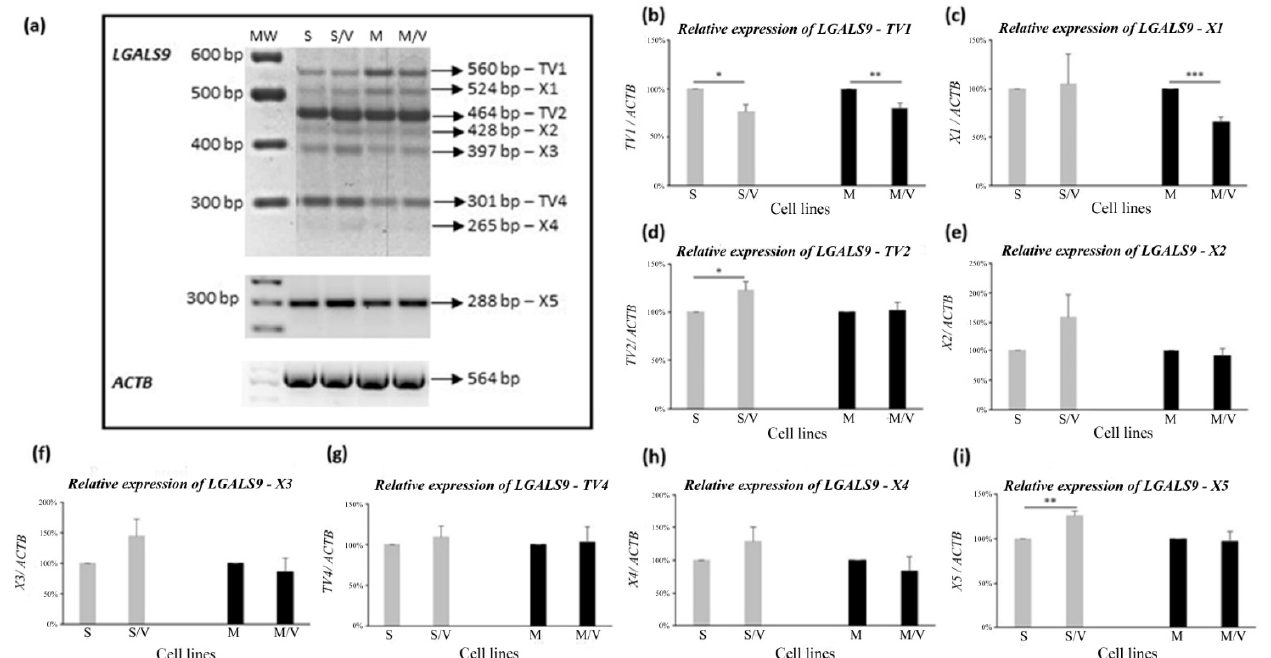
Figure 8. Expression of LGAL9 transcript variants in SKM-1, SKM-1/VCR, MOLM-13 and MOLM-13/VCR cells. ( a ) Representative gel (from 4 independent experiments) of RT-PCR detection of LGALS9 TVs in AML cell lines. All TVs (except X5) were amplified by the same pair of primers designed to produce PCR products with distinct molecular weights; ( b – i )—densitometric quantification of respective PCR product bands obtained by RT-PCR of LGALS9 gene expression in respective cell types. Data represent the mean ± SEM of 4 independent experiments. Statistical significance is as follows: * p ≤ 0.05; ** p ≤ 0.02; *** p ≤ 0.001. MW—molecular weight marker; 1—SKM-1; 2—SKM-1/VCR; 3—MOLM-13;